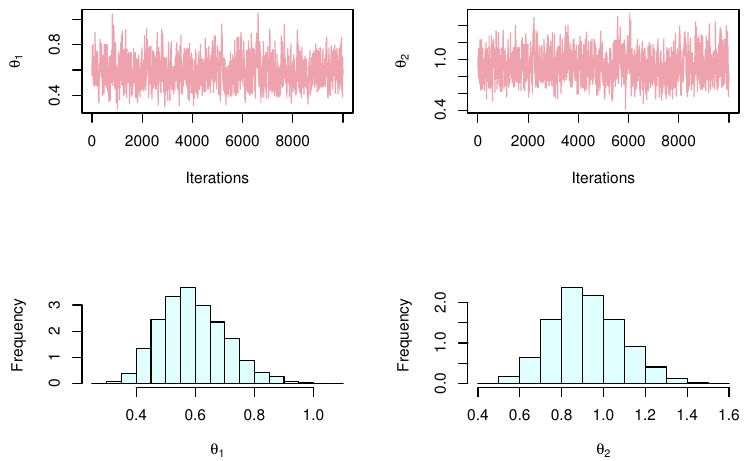
Figure 6. MCMC plot of parameter estimation by SRS method for banking data.